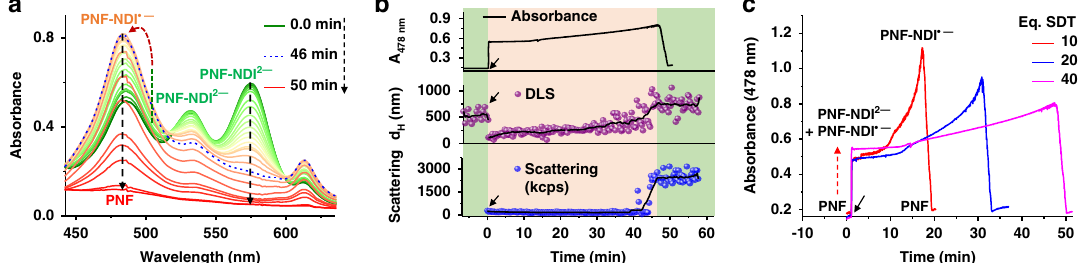
Fig. 4 Temporally controlled supramolecular polymerization. a Absorption spectral changes during the temporal oxidation of the reduced PNF with 40 eq. SDT. b Comparison of time evolution absorbance at 40 eq. SDT with corresponding DLS intensity percentage size data over time along with the scattering (kcps) changes. c Time dependent changes in the absorbance of PNF-NDI (cid:129) − of reduced PNF at 478 nm having 10 eq., 20 eq., and 40 eq. of SDT. Black arrow indicates the point of SDT injection. [PNF] = 5 × 10 − 5 M, CH 3 CN/H 2 O (1:1 v/v), pH = 8,